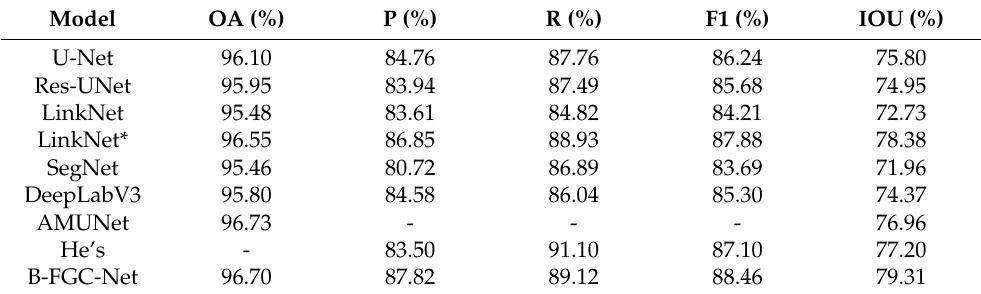
Table 4. Accuracy evaluation results of different methods on the INRIA aerial image labeling dataset. AMUNet and He’s model are implemented by [32] and [3] respectively. Here, ‘-’ denotes the unknown results that were not given by the authors.